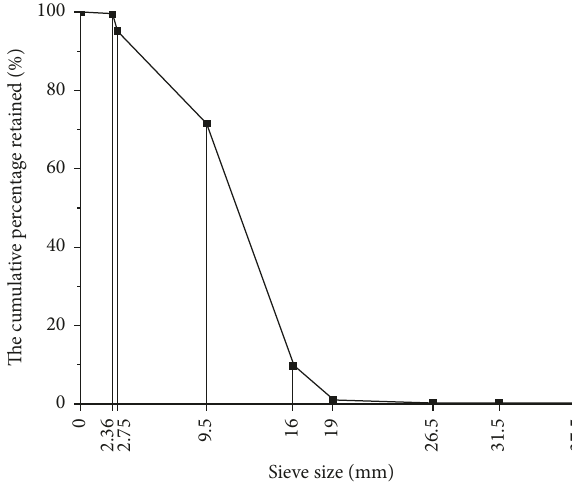
Figure 2: Coarse aggregate sieving curve.